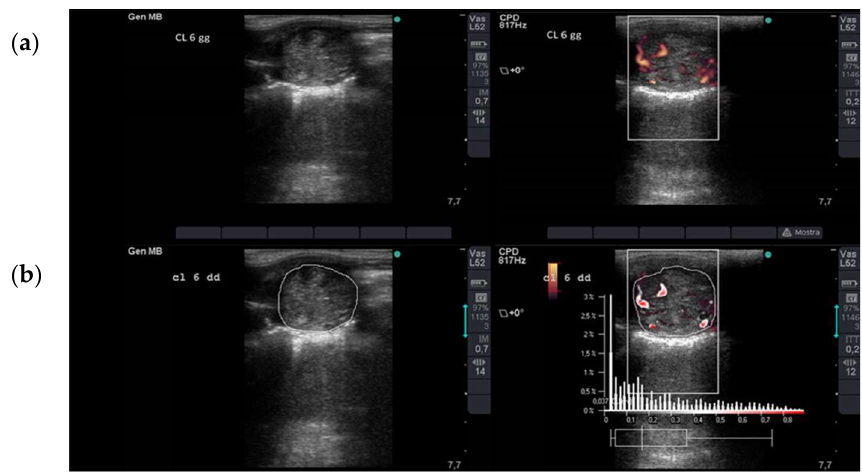
Figure 1. Ultrasonographic assessment of luteal blood flow. ( a ) B-mode ( left ) and Power Doppler ( right ) images of a corpus luteum on Day 6 after ovulation. The images are acquired at the maximum cross-sectional area of the corpus luteum. Using the Power Doppler mode, the color box is superimposed to the corpus luteum, and the blood-flow within the vessels is depicted as colored pixels. ( b ) Computer-assisted image analysis for semi-quantitative estimation of luteal blood flow. The corpus luteum cross-sectional area and the colored pixel area were measured using the software caliper from the B-mode ( left ) and Power Doppler ( right ) images, respectively.